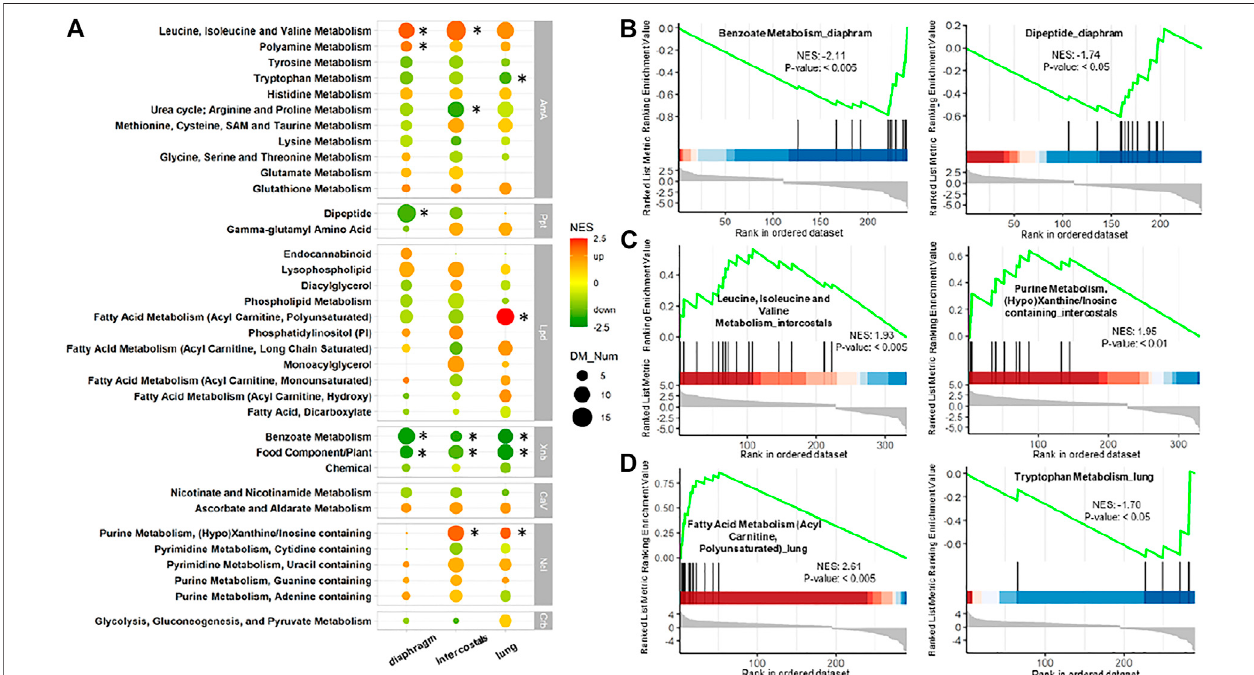
FIGURE 5 | Metabolite set enrichment analysis (MSEA) of DMs in each tissue. (A) Comparison of enriched pathways among three tissues. Pathways are shown when contained DMs ≥ 5 in any tissue. Color scale bar represents normalized enrichment score (NES) which is the indicator of status of the enriched pathways. Green color (negative NES) indicates downregulation, whereas red color (positive NES) indicates upregulation. Dot size represents the number of enriched DMs. * Represents p -value < 0.05 and contained DMs ≥ 5. AmA: amino acid; CaV: cofactors and vitamins; Crb: carbohydrate; Lpd: lipid; Ncl: nucleotide; Ppt: peptide; Xnb: xenobiotics. MSEA-enrichment plot of the top-ranked enriched metabolites set in (B) diaphragm, (C) intercostals, and (D) lung tissue.